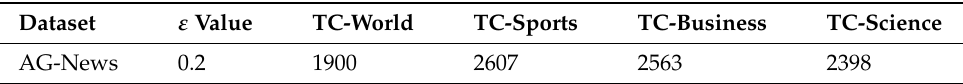
Table 4. Best ε value for the TSC algorithm and tolerance class size for AG-News dataset.